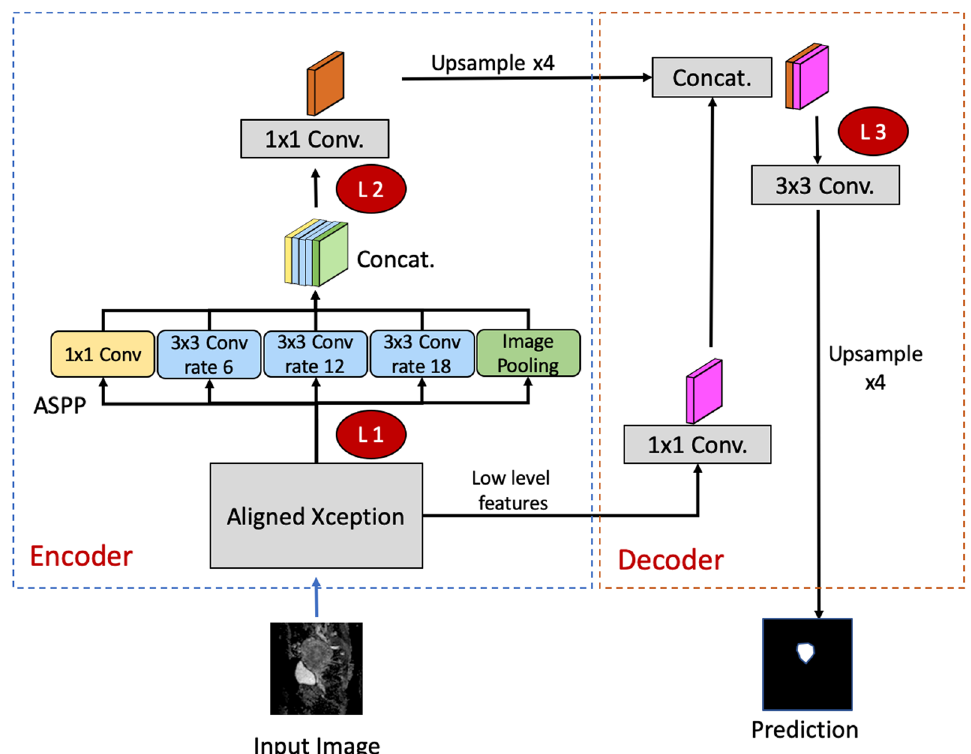
Fig. 1 The DeepLab V3 network architecture in the experiment. The red circle with annotations of L1, L2, and L3 denotes the cutoff levels in + which the previous layers are frozen, whereas the following layers are fine‑tuned based on the target dataset. L1: an early layer in the encoder following the Xception model. L2: a deep layer following the ASPP at the end of the decoder. L3: the layer at decoder initiation. ASPP: Atrous Spatial Pyramid